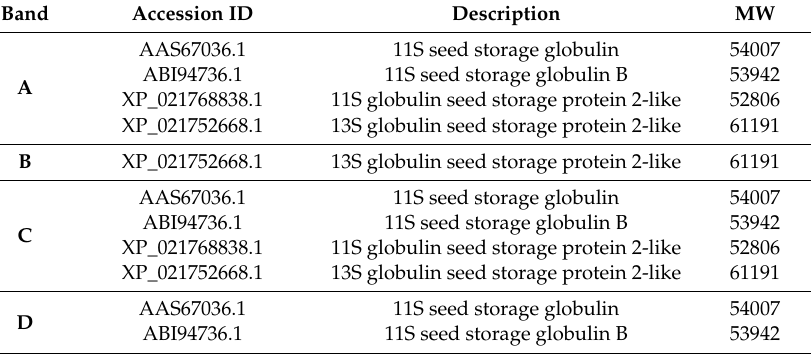
Table 1. List of proteins identified by mass spectrometry (MS). More than one protein was found in each of the four ( A – D ) separated bands. MWs refers to the unprocessed precursors as reported by data banks. Statistical information, experimental data, and sequences of the MS attributions are provided in Supplementary Table